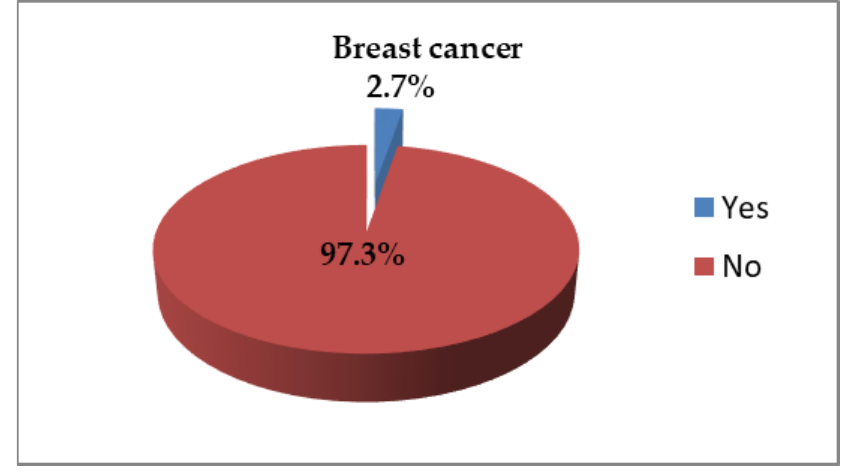
Figure 3. Frequency distribution of breast cancer diagnosis ( p value = 0.736).